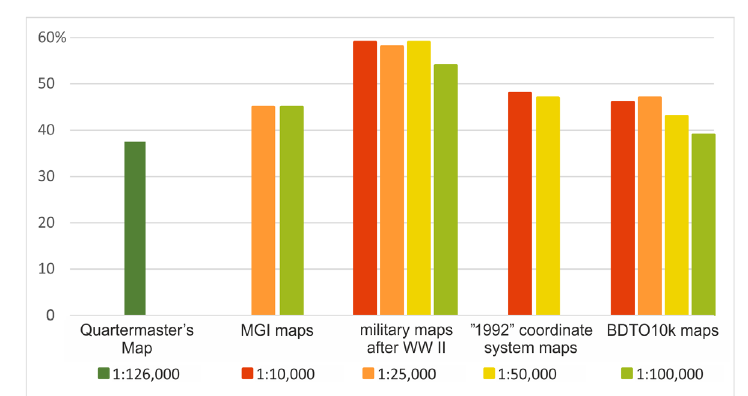
Fig. 9. Share of physiognomic characteristics in the overall number of characteristics of built-up area